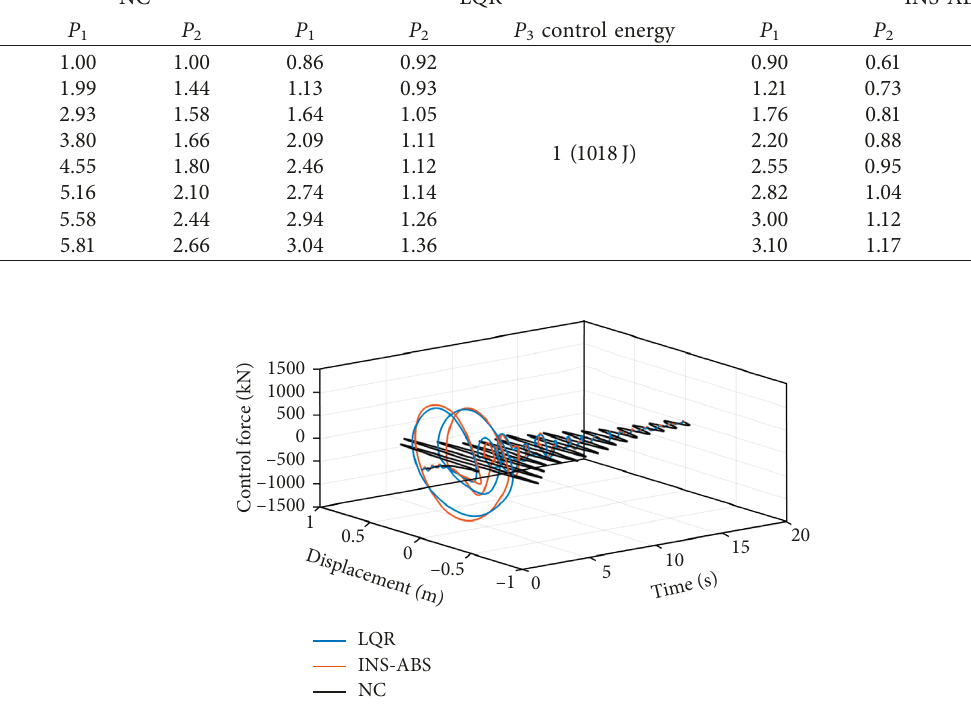
Figure 4: Top story displacement and control forces for Northridge